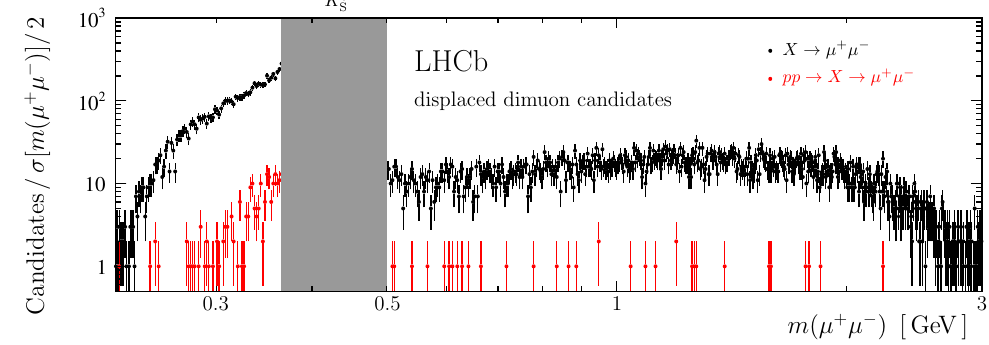
Figure 2 . Displaced dimuon mass spectra showing the (black) inclusive and (red) promptly pro- duced candidates with all (cid:12)ducial and selection requirements applied. The grey box shows the region vetoed due to the large doubly misidenti(cid:12)ed K 0 background, whose low-mass tail extends into the S search region. A dedicated study of this region is presented in a search for K 0 (cid:22) + (cid:22) (cid:0) decays S !